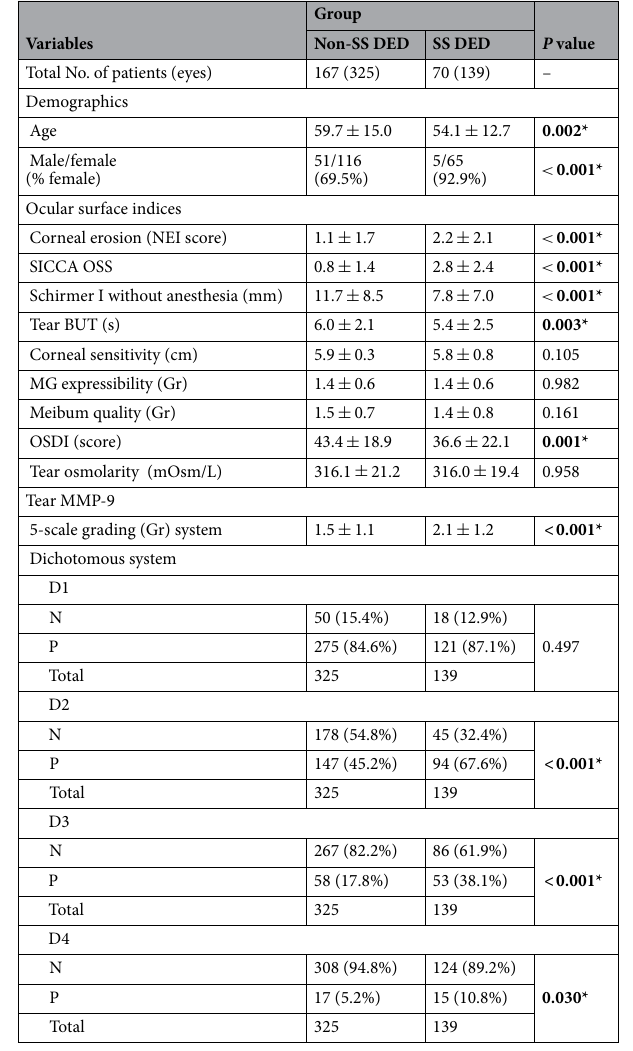
Table 1. Demographics and ocular surface indices in subjects with dry eye disease (DED) with and without primary Sjogren’s syndrome (pSS). * P < 0.05. Gr, grade. OSDI, ocular surface disease index. OSS, ocular staining score. BUT, break-up time. MG, meibomian gland. MMP-9, matrix metalloproteinase 9. N, negative. P. positive. Significant are in value